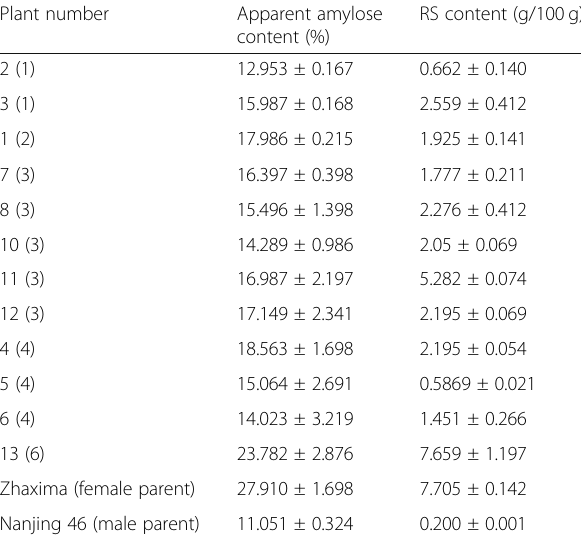
Table 5 Amylose starch content and resistant starch (RS) content of regenerated rice plants a Plant